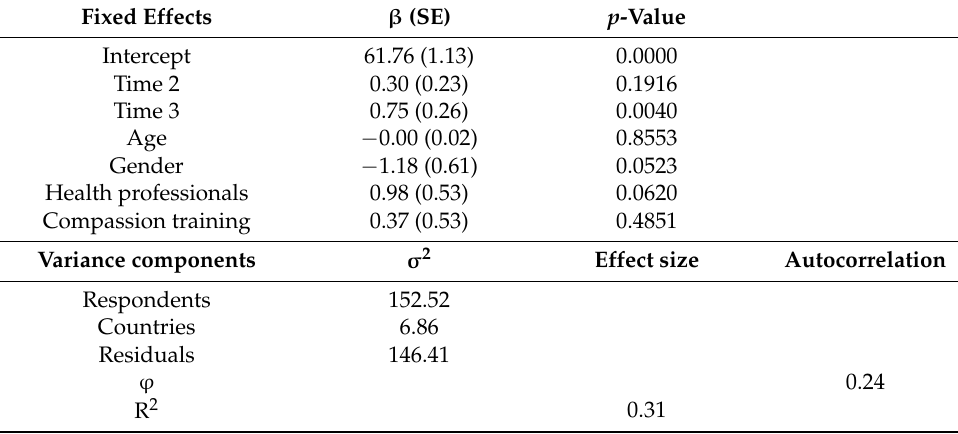
Table 3. Estimates of the final model for compassion from others.